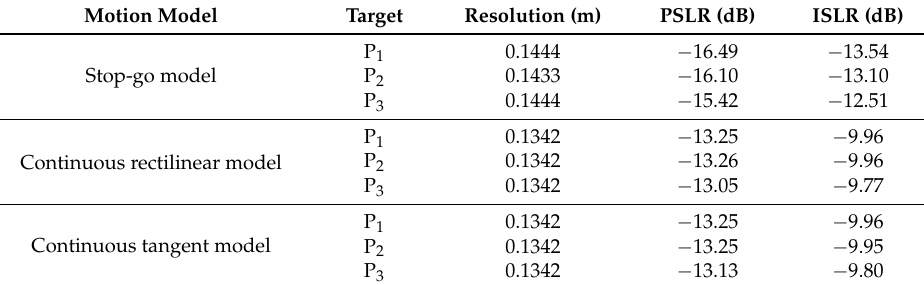
Table 3. Evaluation of imaging quality along range.